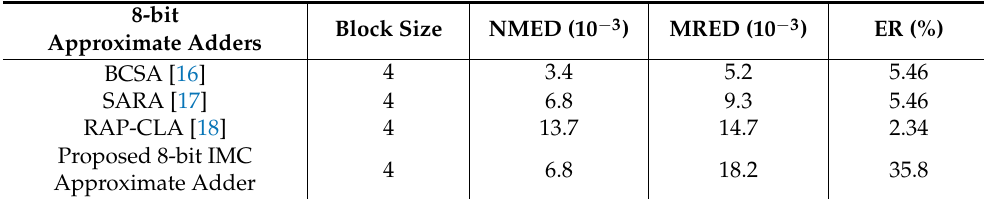
Table 6. Comparison of errors in different approximate adders (8-bit, block size of 4).